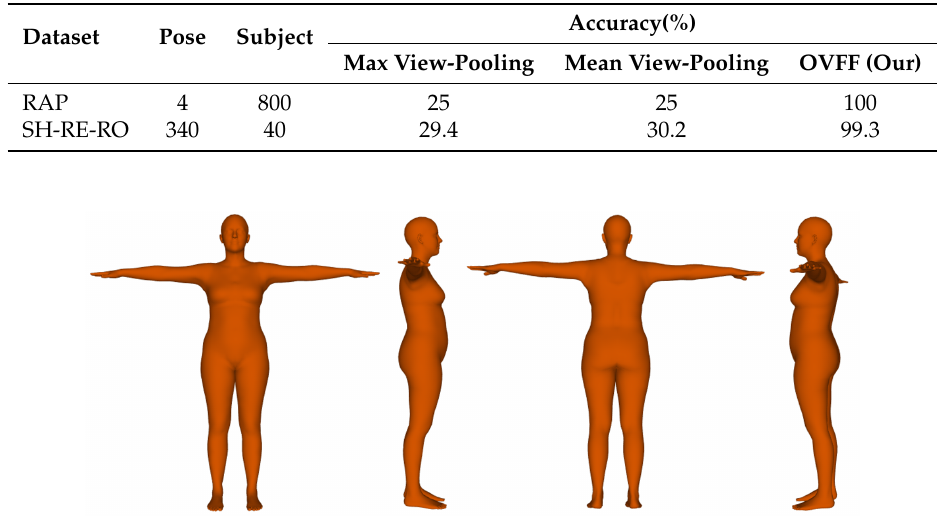
Figure 12. The given pose and its three rotated ones in the dataset RAP.